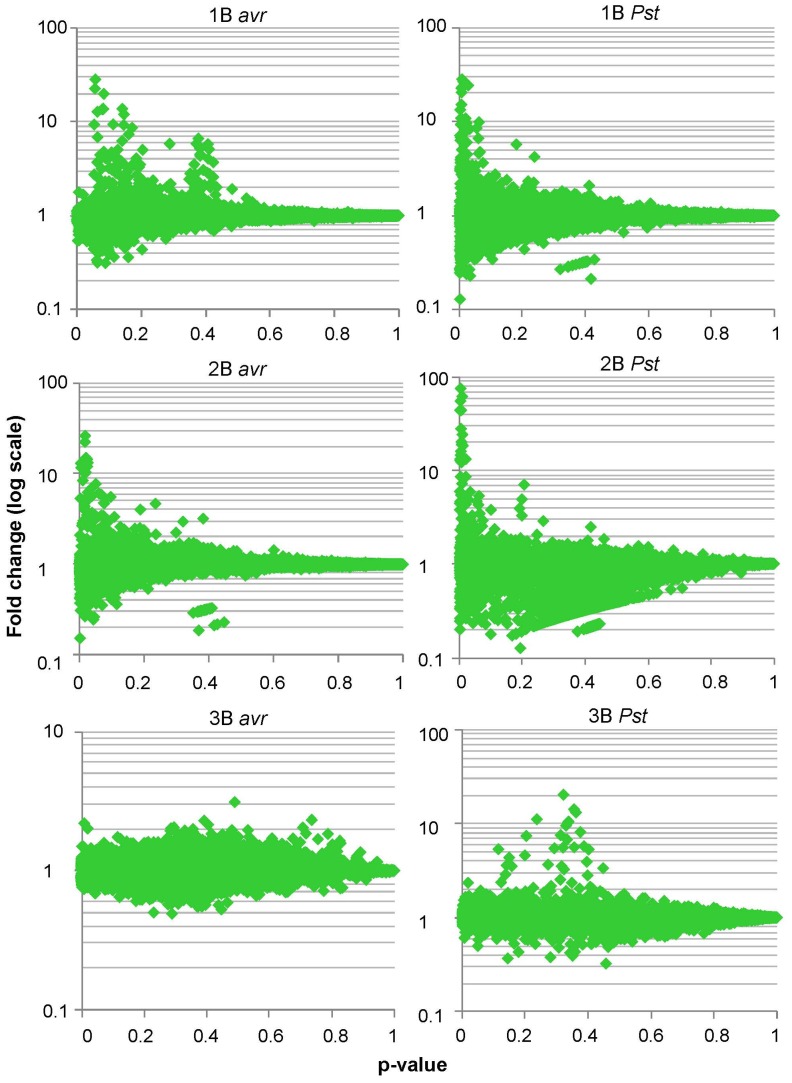
Microarray analysis shows significant fold-changes in rounds 1 and 2 of Pst and Pst(avrRpt2) (avr) bio-pannings.cDNA from the T7LAtPs library (L) and the clones selected after bio-panning rounds 1, 2 or 3 (1B, 2B or 3B) were hybridized to microarrays. For each gene spotted in the microarray the B/L ratio and the statistical significance of B/L≠1 were determined. The plot represents the B/L ratio as a fold-change in the Y-axis (log values centred around 1) and the p-values for the statistical test in the X-axis. Best candidates to be Pseudomonas-bound clones are represented by the spots with highest fold-change and lowest p-values, which are located on the top-left area of the graph.